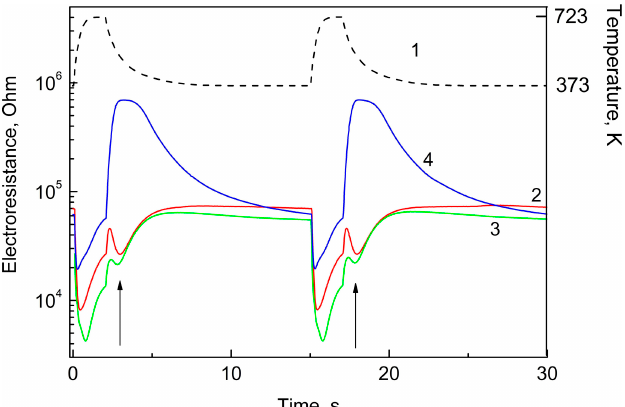
Figure 1. The temperature of the sensor (curve 1) with sensing layer consisting of tin dioxide decorated wiht Pd and sensing layer resistance at this temperature modulation as a function of time during temperature modulation cycle. (2) 100 ppm of H 2 , (3) 100 ppm of ethanol, (4) 100 ppm of CO in air.